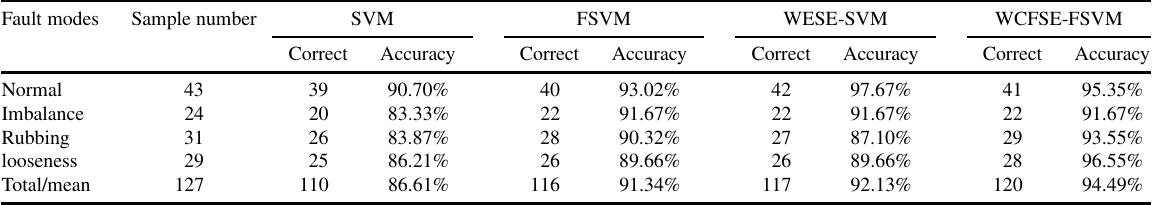
Table 3 Diagnosis results of four methods (SVM, FSVM, WESE-SVM and